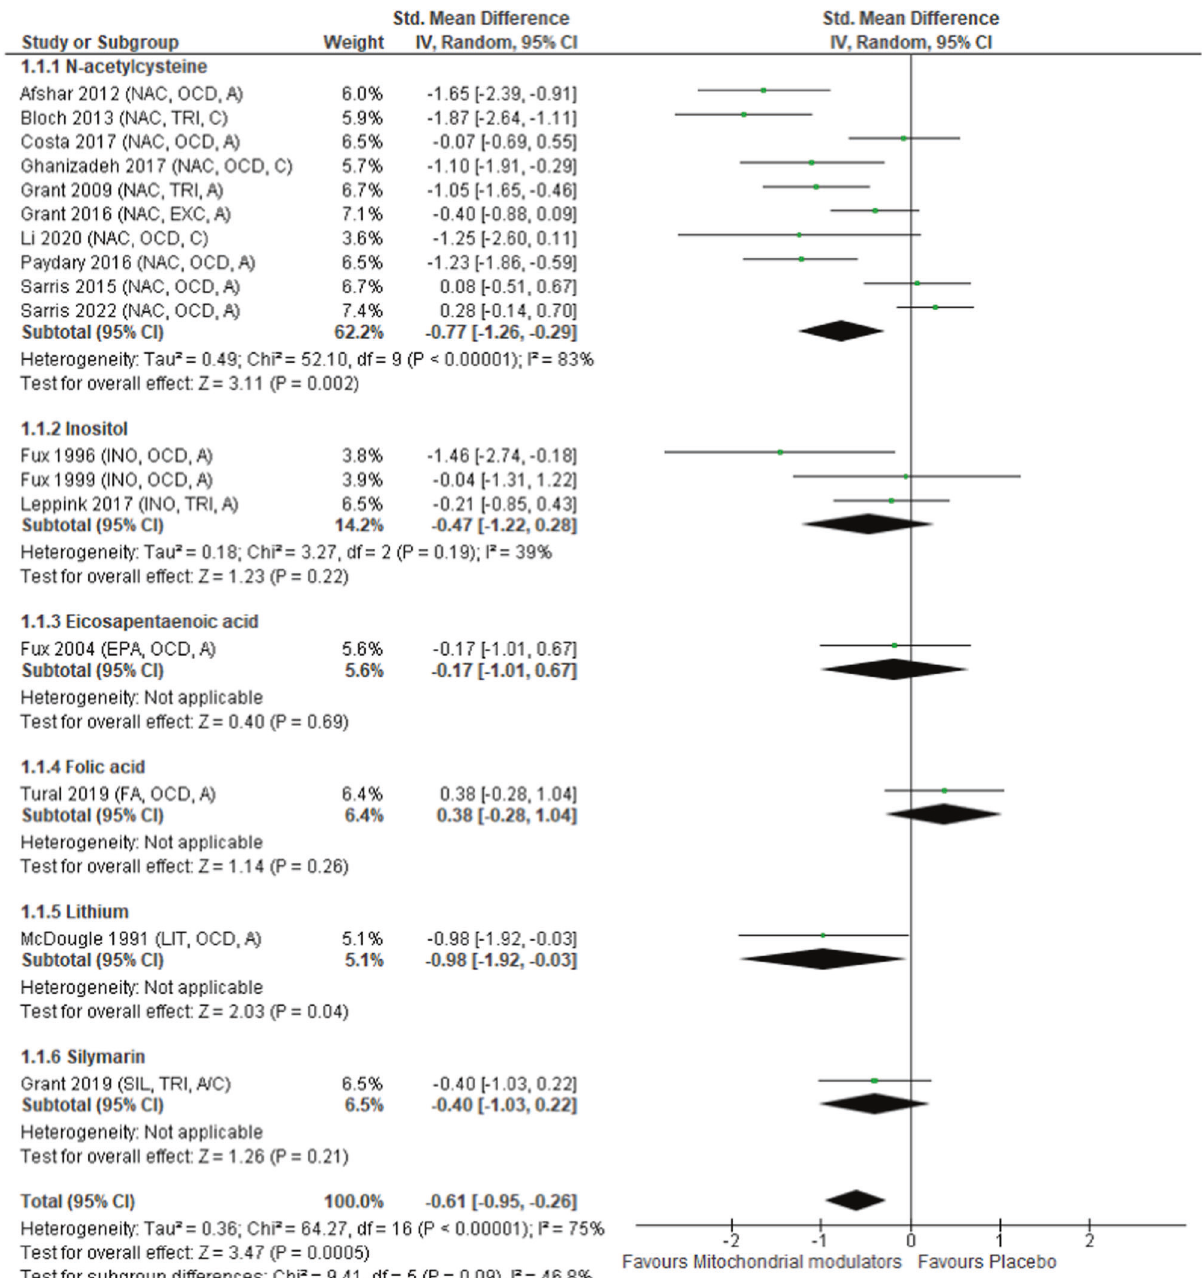
Fig. 1 Forest plot for overall symptoms. Studies are listed by names of the fi rst authors and year of publication, with abbreviations for drugs listed in parentheses ( A , B , C ). A Listing by mitochondrial modulator name. EPA eicosapentaenoic acid, FA folic acid, INO inositol, LIT lithium, NAC N-acetylcysteine, SIL silymarin. B Listing by diagnosis. EXC excoriation disorder, OCD obsessive – compulsive disorder, TRI trichotillomania. C Listing according to adults ( A ) or children ( C (PRISMA) guidelines (Appendix S1) [12] and were registered with the Open Science Framework (https://osf.io/h4ypt). The literature search, data transfer accuracy, and statistics were each double-checked by at least two of the authors.